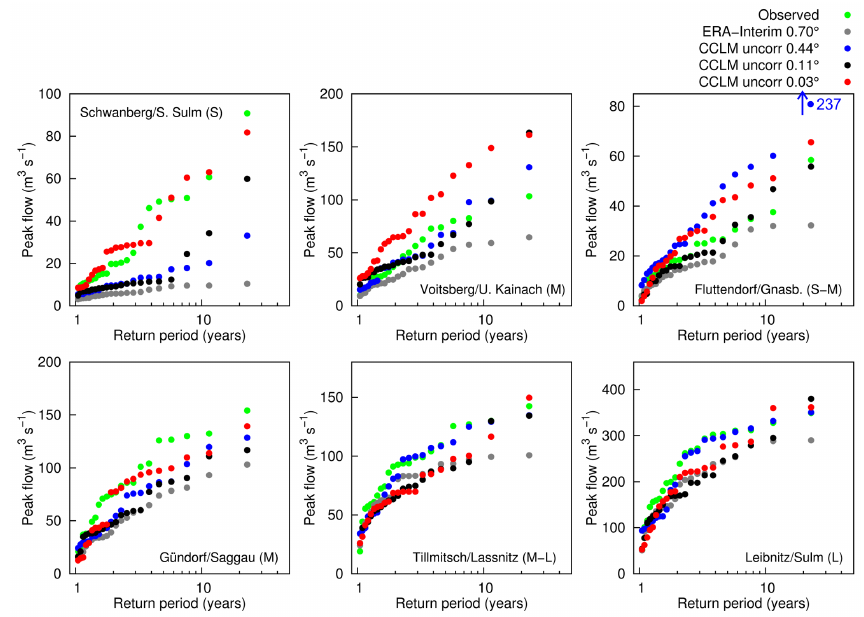
Figure 7. Simulated maximum annual flood peaks using raw CCLM data as input and observed maximum annual flood peaks vs. empirical return periods (Eq. 1, flood frequency plots) of the selected gauges in the period 1989–2010.